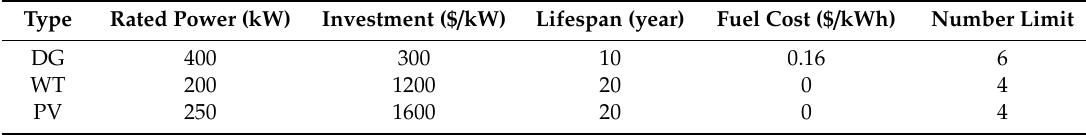
Figure 11. Structure of the IEEE 69-bus distribution system based MG. Table 11. Technical Parameters of DERs. Table 12. Technical Parameters of BSs.